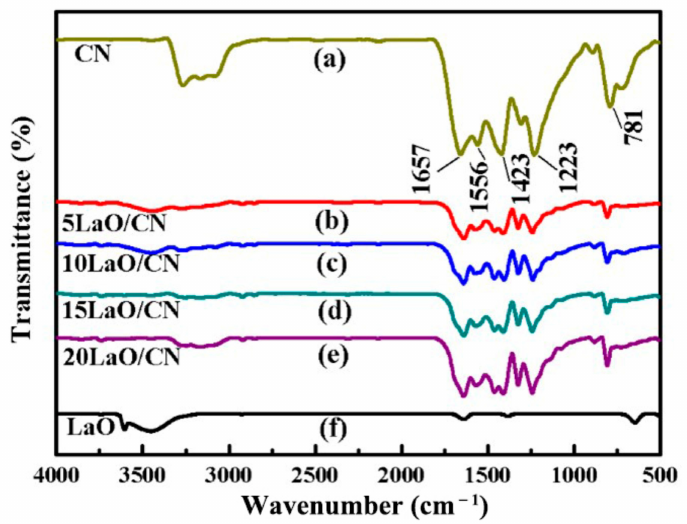
Figure 3. FTIR patterns of CN sample (a), 5LaO/CN sample (b), 10LaO/CN sample (c), 15LaO/CN sample (d), 20LaO/CN sample (e), LaO sample (f).